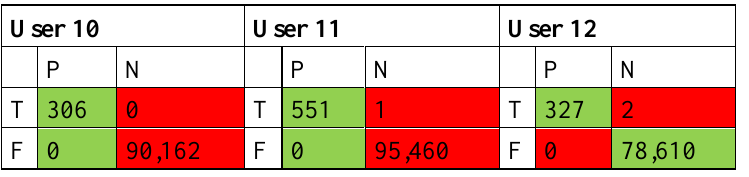
Table 5. Confusion matrix for the R wave IV.